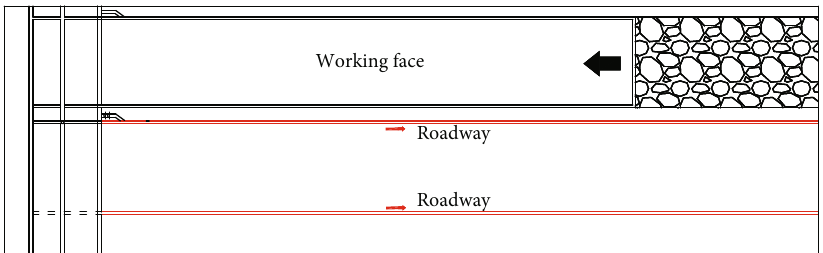
Figure 1: Schematic diagram of reverse mining and excavation.